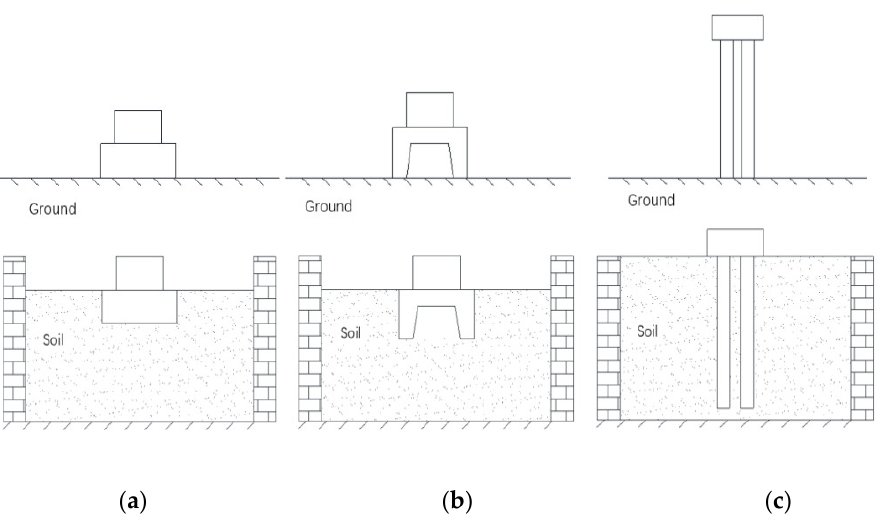
Figure 10. Foundation models located on the ground and fully buried in the soil: ( a ) spread founda- tion; ( b ) caisson foundation; ( c ) grouped pile foundation.